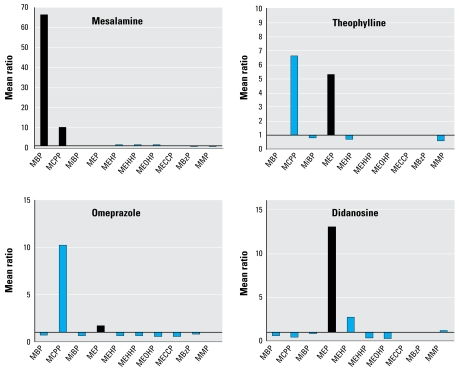
Mean ratio of creatinine-adjusted urinary concentrations of phthalate metabolites among users of specific medications compared with nonusers, NHANES 1999–2004. Abbreviations: MBzP, monobenzyl phthalate; MECCP, mono-(2-ethyl-5-carboxypentyl) phthalate; MEHHP, mono-(2-ethyl-5-hydroxyhexyl) phthalate; MEHP, mono-(2-ethylhexyl) phthalate; MEOHP, mono-(2-ethyl-5-oxohexyl) phthalate; MiBP, monoisobutyl phthalate; and MMP, monomethyl phthalate. Black bars indicate phthalates that might have been contained in each medication. The observed elevated MCPP concentrations for theophylline and omeprazole might result from the high-molecular-weight phthalates presumably contained as inactive ingredients in some generic versions.